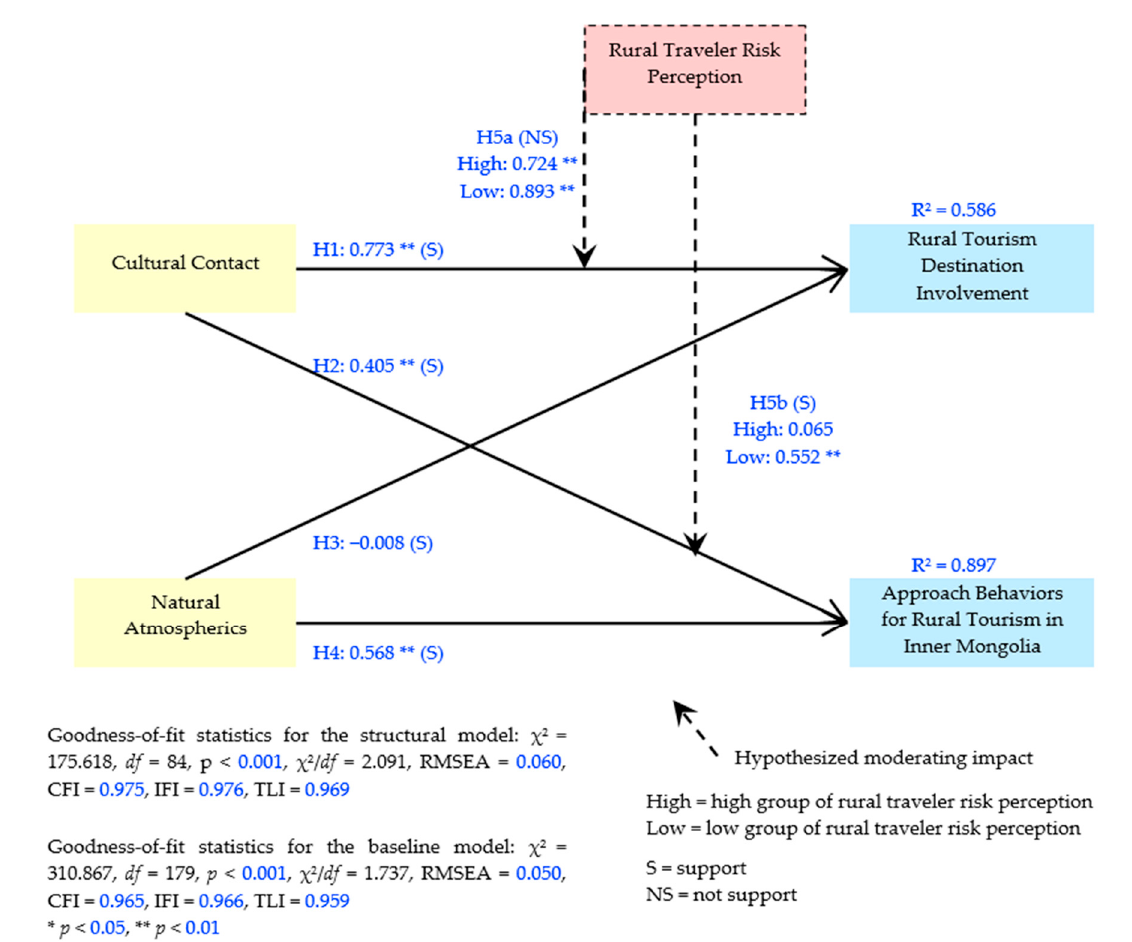
Figure 2. Structural analysis and invariance assessment results.